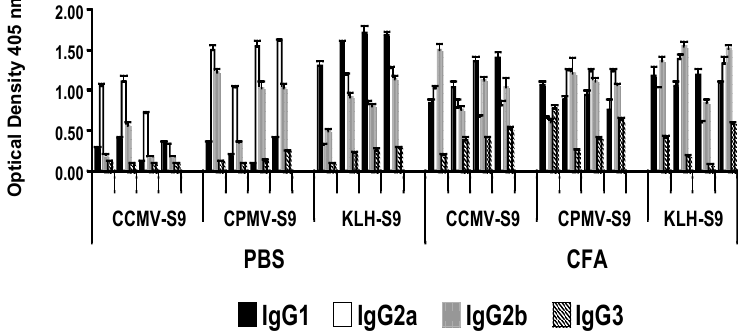
Figure 3. IgG subclasses of anti-S9 antibody response. Post-immune sera of individual mice immunized with the indicated antigens were tested by ELISA in wells coated with the S9 peptide. Antibodies of the different IgG subclasses were detected with alkaline phosphatase-conjugated subclass-specific antibodies.